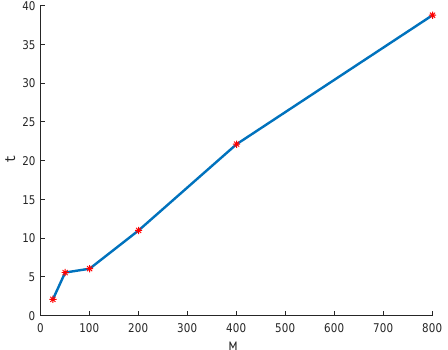
Figure 3. The graph of the variety of the computational time with M